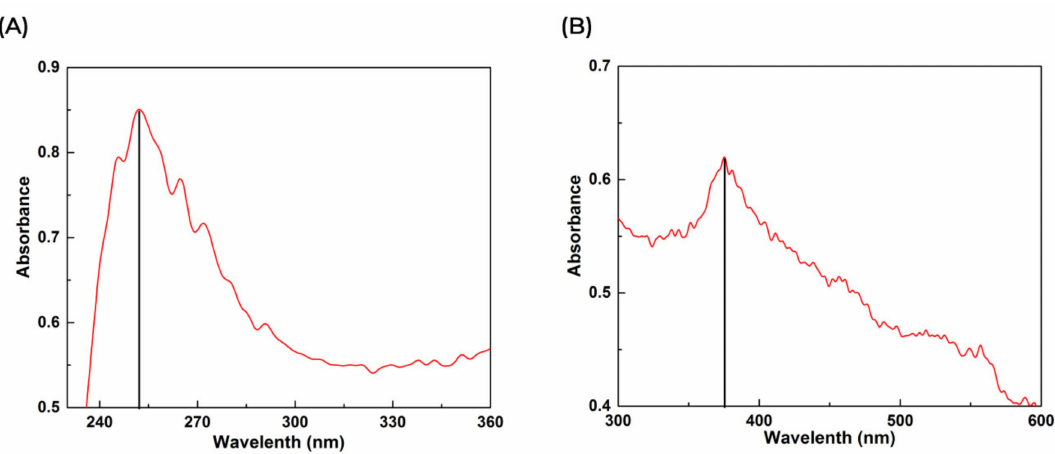
Figure 1. Ultraviolet–visible spectral analysis of synthesized ZnO ( A ) and green synthesized ZnO NPs ( B